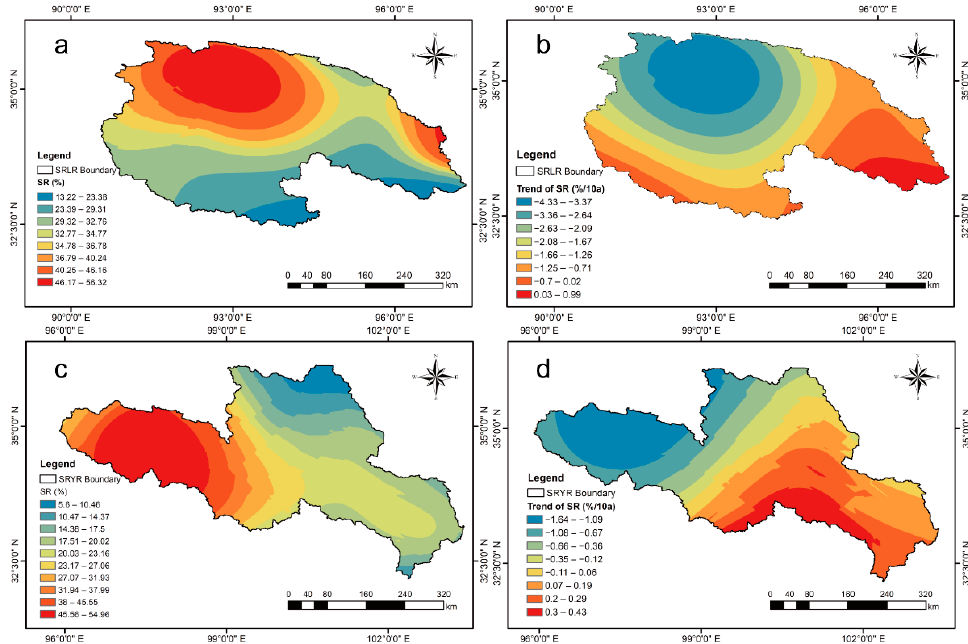
Figure 5. Spatial distribution of SR and SR trend in the study region during1979–2018: ( a ) SR of SRLR; ( b ) SR trend of SRLR; ( c ) SR of SRYR; ( d ) SR trend of SRYR.